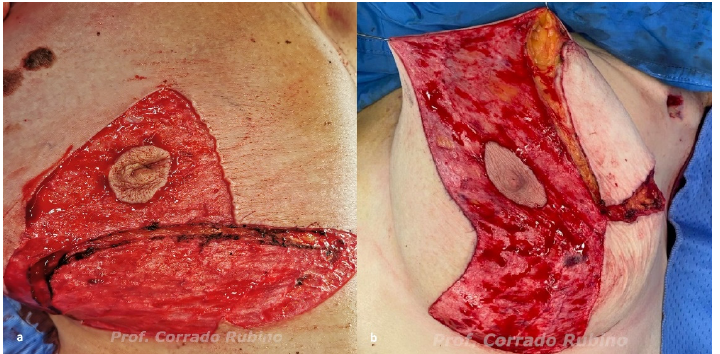
Figure 3. Different types of access for nipple/skin-sparing mastectomy: ( a ) type IV mastectomy is performed through a full thickness incision performed along the superior border of the inferior dermal flap; ( b ) type V mastectomy is performed through a full incision performed along the borders of the upper quadrant that has to be removed.